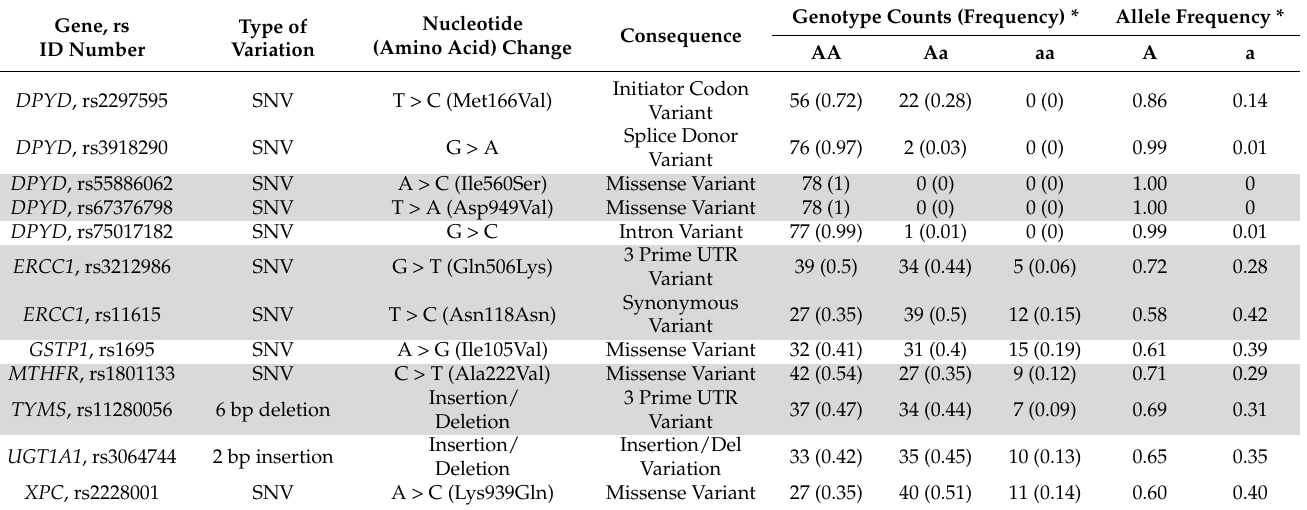
Table 2. Genes, genetic variations, genotype, and allele frequencies in PDAC patients ( n = 78).